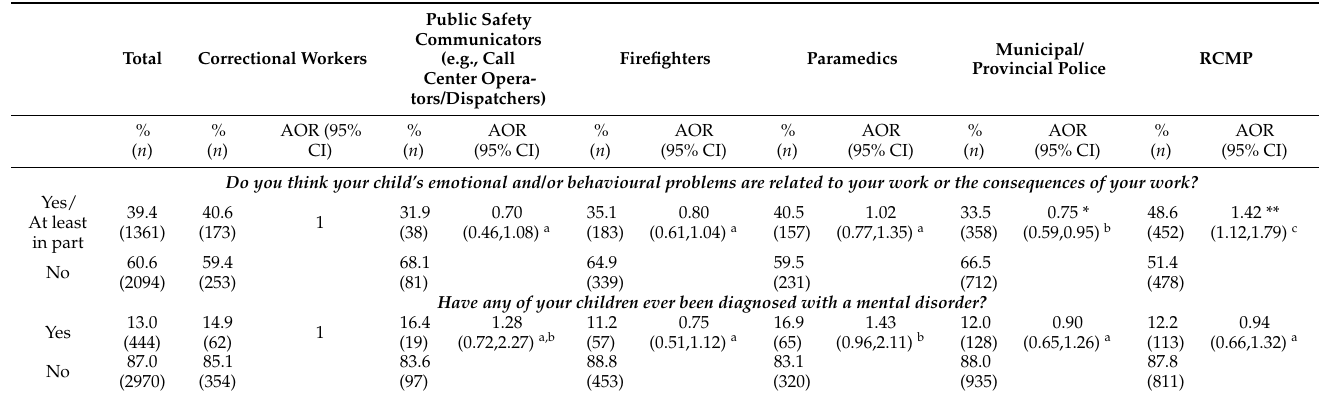
Table 4. Association between the child’s emotions and/or behaviours and parent’s work as public safety personnel and prevalence of mental health disorder diagnosis among children of public safety